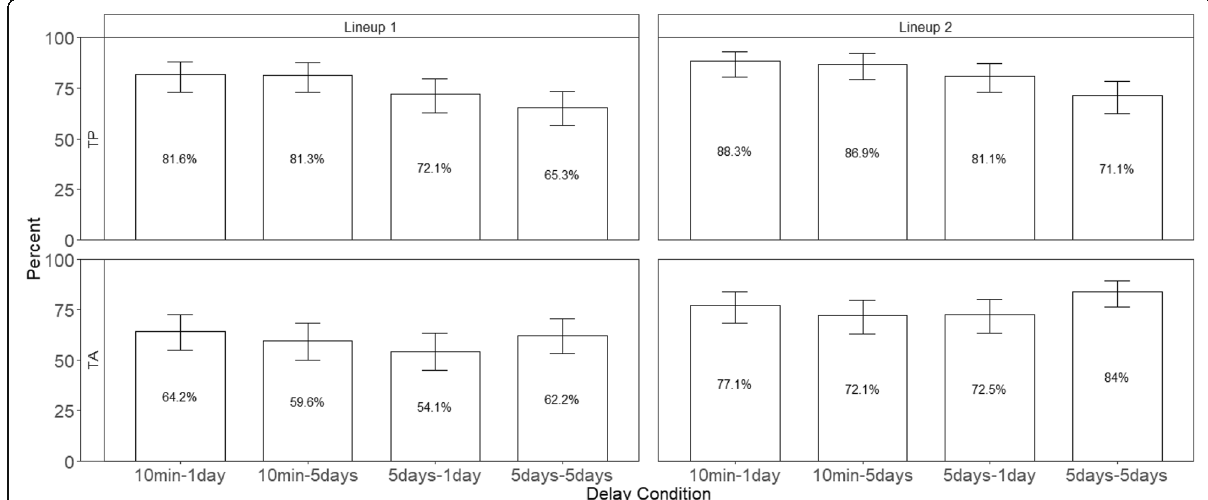
Fig. 3 The percentage of choosers across lineups and delay conditions in Experiment 2. The top panels show the target-present lineups and the bottom panels show the target-absent lineups. Error bars represent 95% confidence